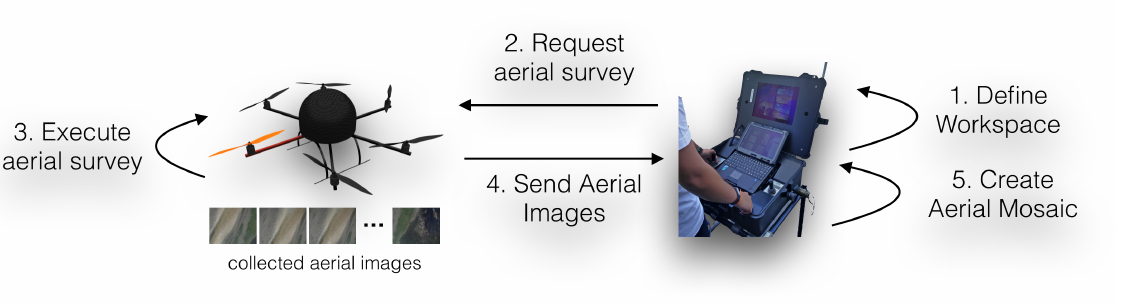
Figure 15. Mission preparation interaction pattern.